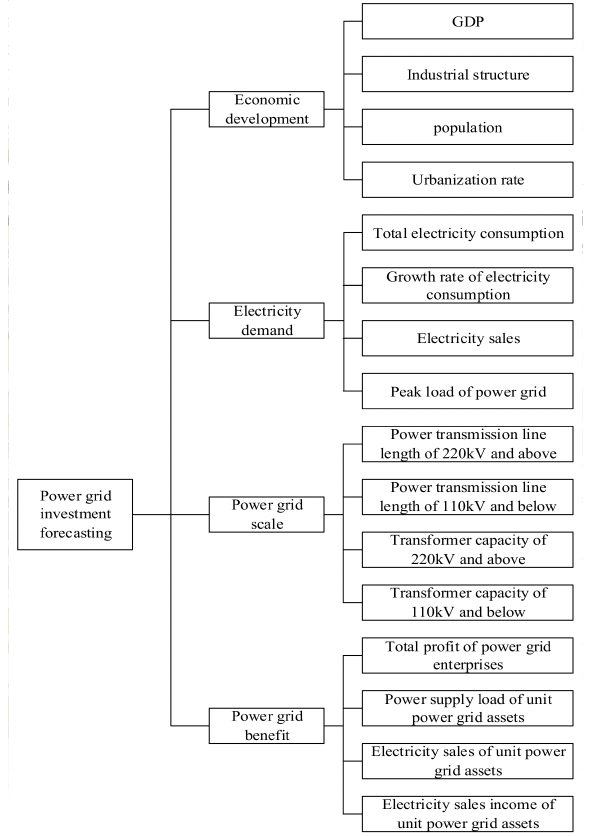
Figure 1. Influencing factors system for power grid investment